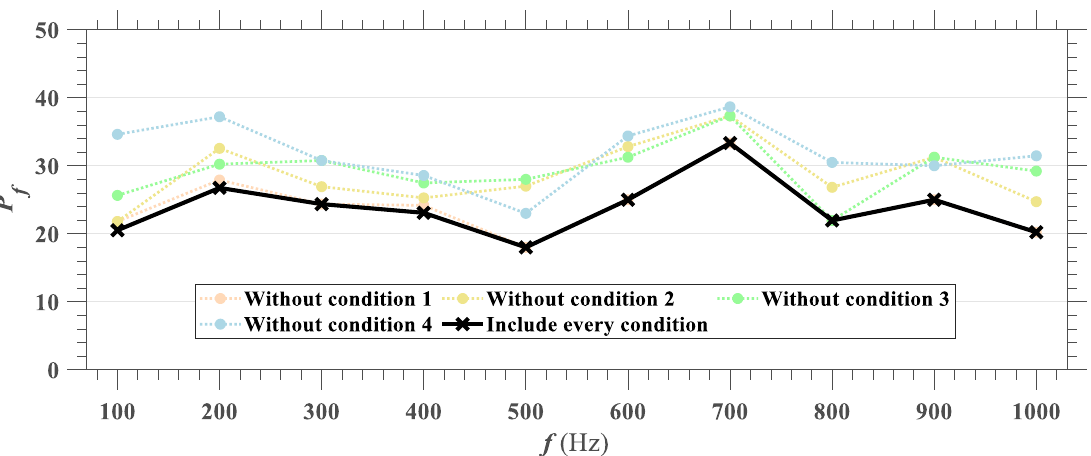
Figure 4. Ratio of larvae responding to sound stimuli for frequency range between 100–1000 Hz for different combinations of four conditions established to define larval response. Correlation coefficients ( r ) between response ratio satisfying four conditions and three conditions (excluding each condition respectively) was computed as r 1 = 0.98, r 2 = 0.77, r 3 = 0.65 and r = 0.64, where the lower letter indicates which condition was excluded.